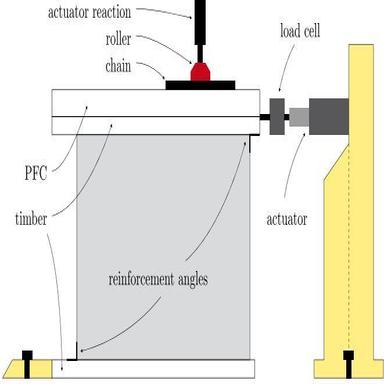
Analytical structural system of the shear tests.